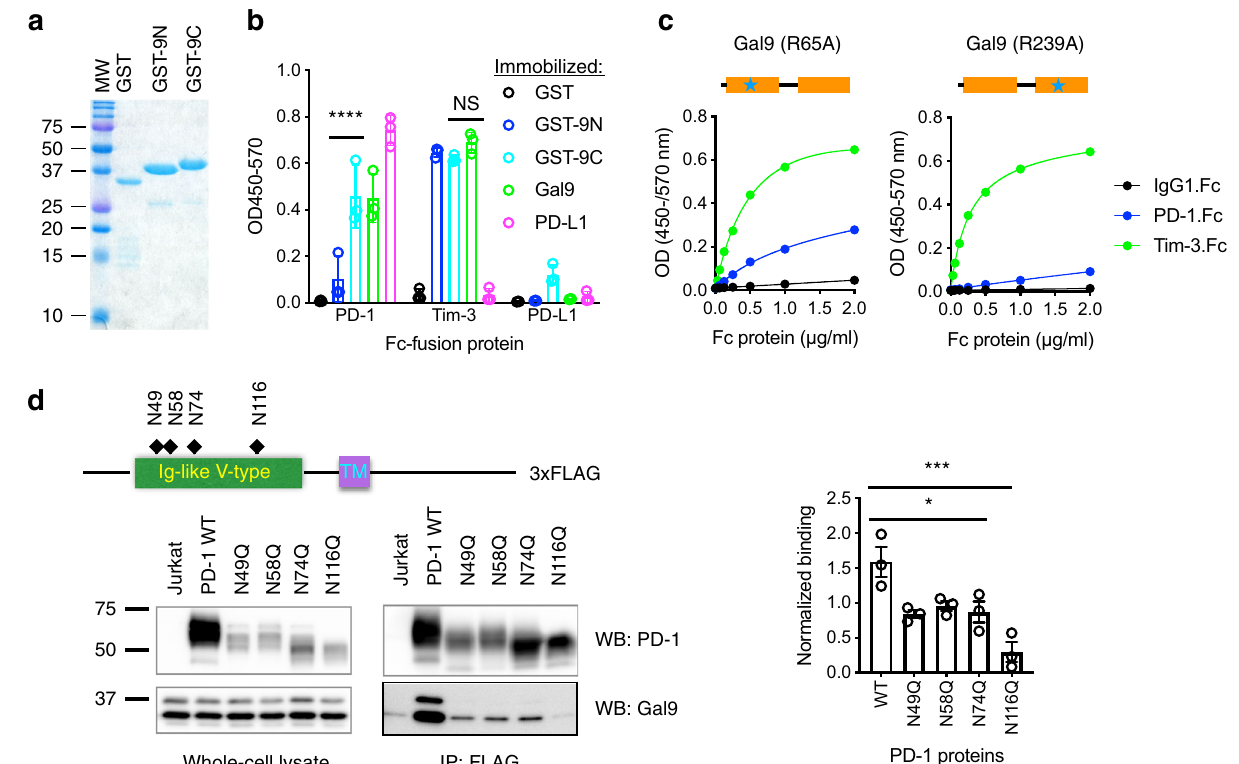
Fig. 2 Binding of Gal-9 to PD-1 is primarily mediated by the C-CRD of Gal-9 and the N116-linked glycan of PD-1. a SDS-PAGE of GST and GST-fusion proteins of the N-CRD (GST-9N) and C-CRD (GST-9C) of Gal-9. b Plate-based binding assay measuring the binding of PD-1, TIM-3, and PD-L1 to indicated proteins immobilized on MaxiSorp plates. n = 3 independent experiments. Error bars represent SD. Statistical differences were assessed using two-way ANOVA with Tukey ’ s multiple comparisons test. **** P < 0.0001. c Plate-based binding assays of PD-1 and TIM-3 binding to immobilized Gal-9 mutants with loss-of-function point mutation in the N-CRD (R65A) or C-CRD (R239A), respectively. d Lysates of Jurkat cells expressing 3xFLAG-tagged WT PD-1 or glycosylation site mutants were incubated anti-FLAG M2 magnetic beads. Bound proteins were eluted and subjected to Western blotting with PD-1 or Gal-9 antibodies. Statistical differences were assessed using ordinary one-way ANOVA with Dunnett ’ s multiple comparisons test. * P < 0.05; *** P < 0.001. WT vs N49Q, P = 0.0113; WT vs N58Q, P = 0.0302; WT vs N74Q, P = 0.0148; WT vs N116Q, P = 0.0002. Data are representative of two ( a , c ) or three ( d ) experiments. Source data are provided as a Source data fi